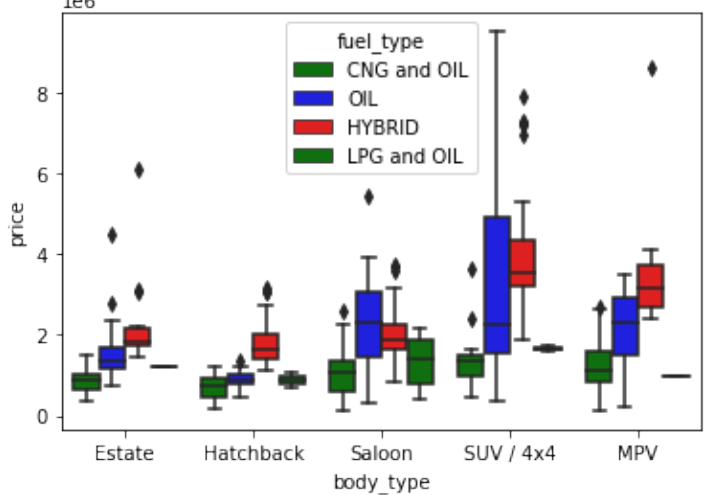
Figure 8. Box plots for different body_type and fuel_type features.